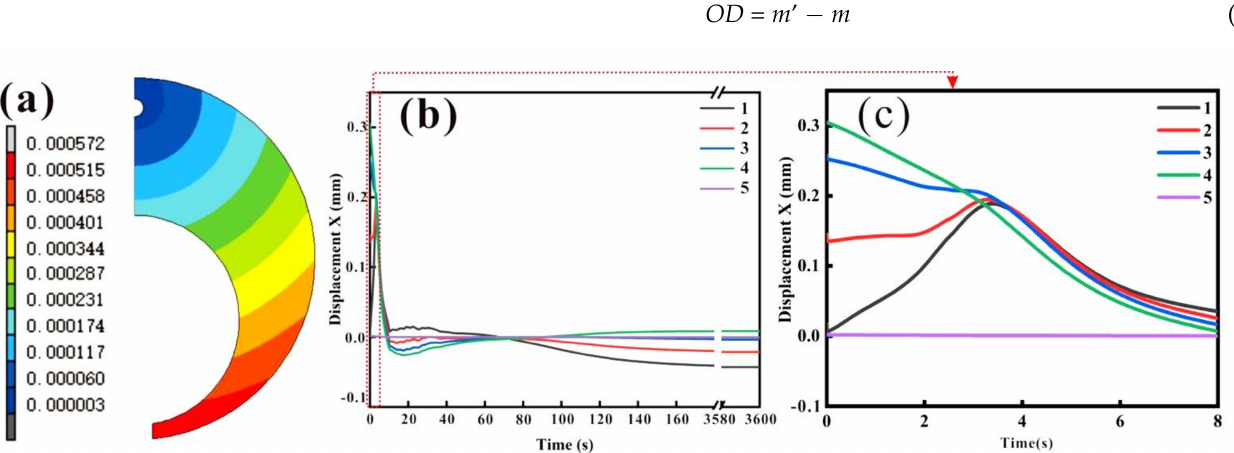
Figure 11. Simulated quenching deformation ( a ) in the x direction of the points in the longitudinal cross-section of the C-ring (displacement magnified 20 × ); ( b ) with time at typical position of C-Nary rings; ( c ) enlarged view of the position marked with dotted line in the ( b